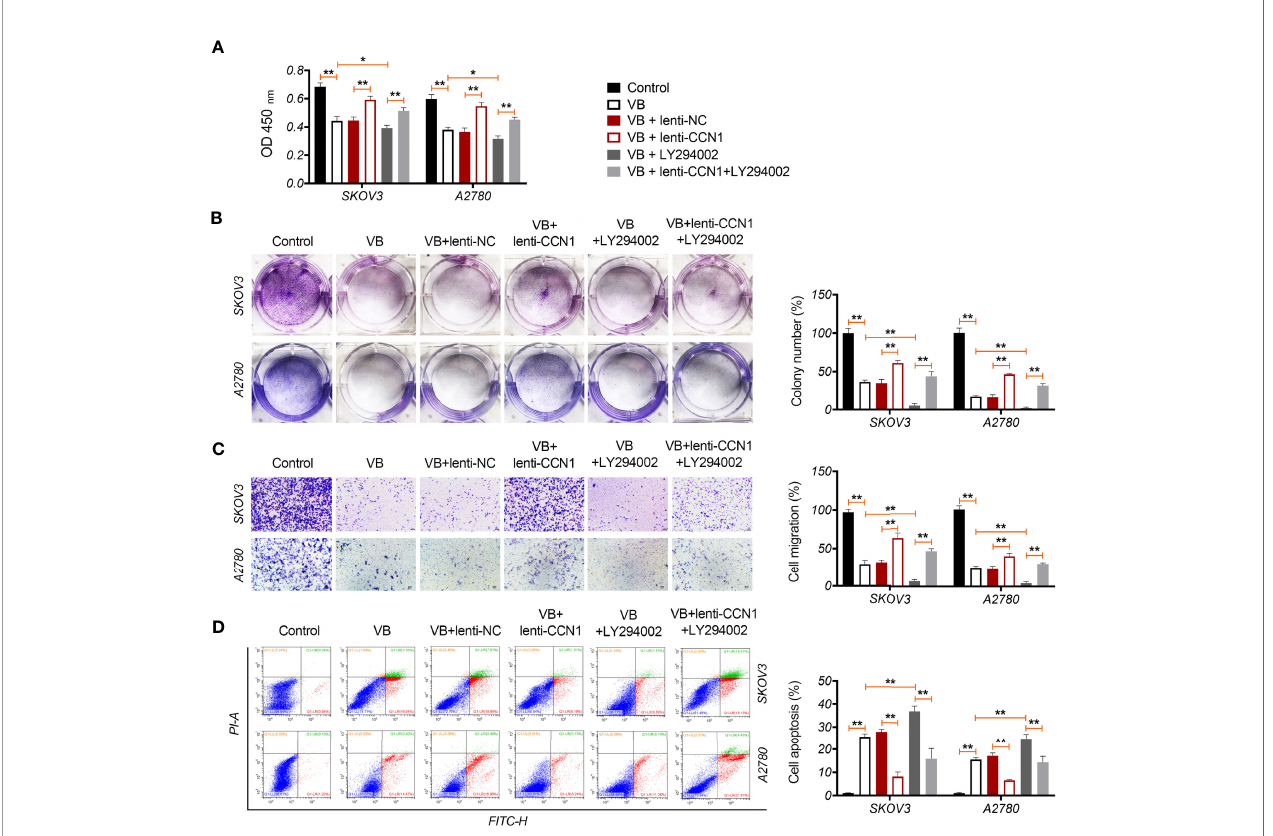
FIGURE 4 | VB suppresses the malignant progression of OC cells via CCN1-mediated AKT/NF- k B pathway. (A) The viability of A2780 and SKOV3 cells was measured by CCK8 assay. (B) The proliferation of A2780 and SKOV3 cells was detected by colony formation assays. (C) The migration of A2780 and SKOV3 cells was detected by transwell assay. Scar bar = 50 µm. (D) The apoptosis of A2780 and SKOV3 cells was measured by fl ow cytometry. Each treatment was replicated three times. Error bars represent the mean ± SD; * P < 0.05 and ** P < 0.01.